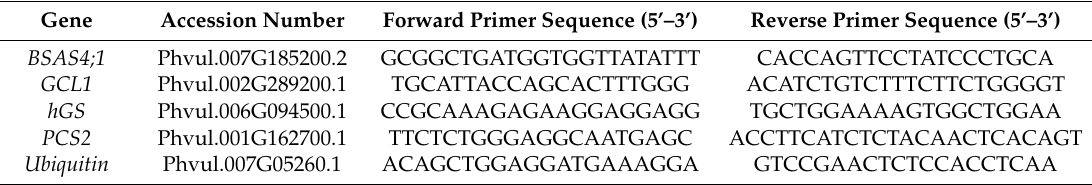
Table 2. Primer sequences used for